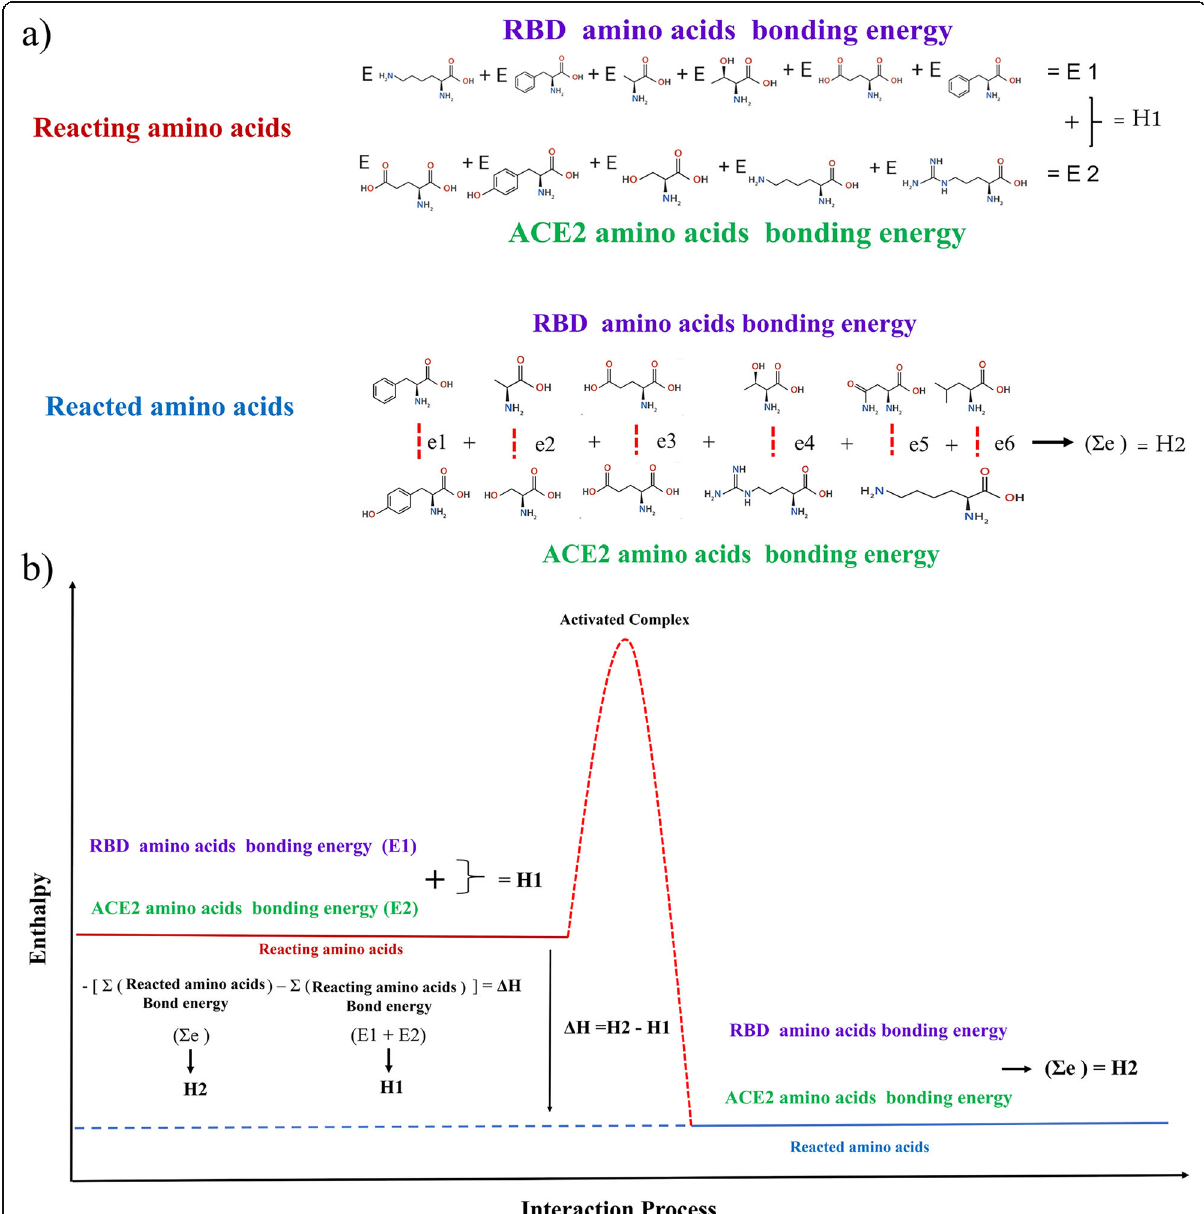
Fig. 2 The changes in enthalpy of the SARS-CoV-2/ACE2 host cell system on the association. H1 represents the total reacting amino acids bond energy by adding RBD amino acid binding energies (E1) to ACE2 amino acid binding energies (E2). H2 represents the total reacted amino acids bond energy by adding binding energy of each RBD amino acid to ACE2 amino acid (e1 + e2 + … = Ʃ e). Negative values of Δ H indicate the higher potential binding energy level of reacting amino acids (H1 >